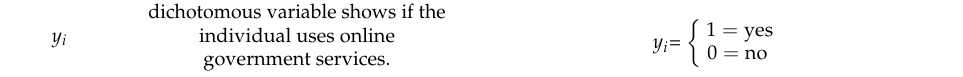
Table 1. Variable